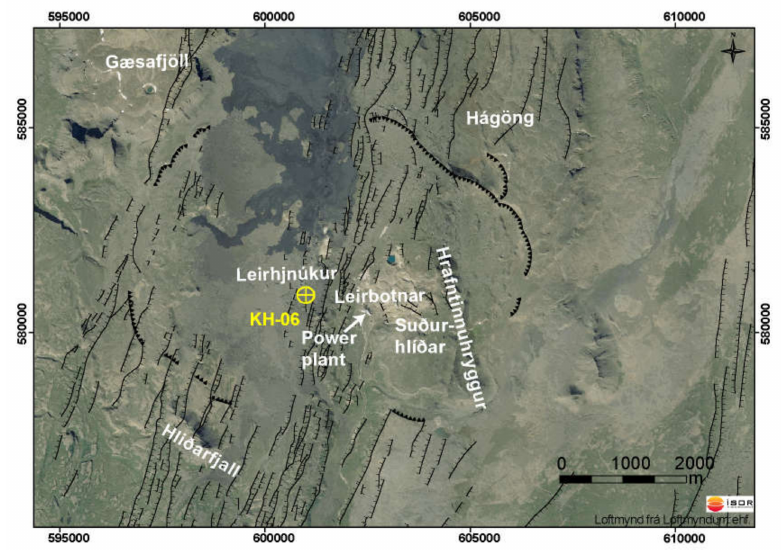
Figure 2. Aerial photograph showing the location of well KH6 within the Krafla geothermal field. Fissures are shown as thin lines, and the Krafla caldera rims are also